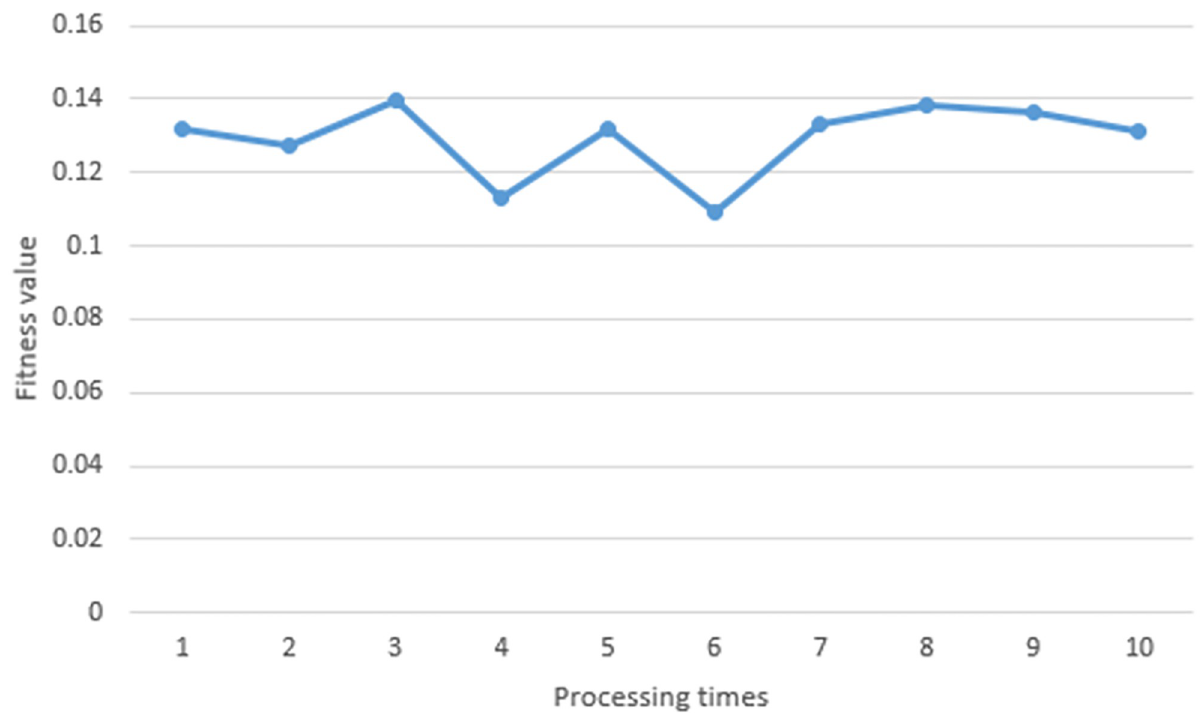
Fig 30. The fitness value obtained in a static environment (6